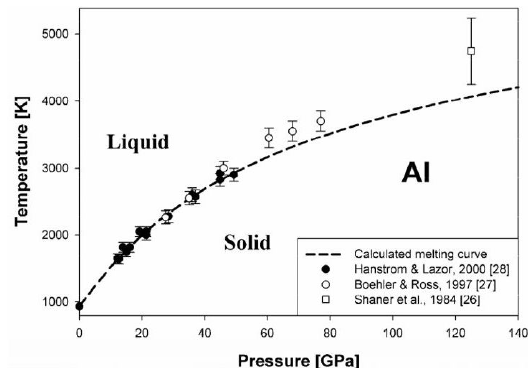
Figure 1. Coexistence curve for solid and liquid aluminum 5 .